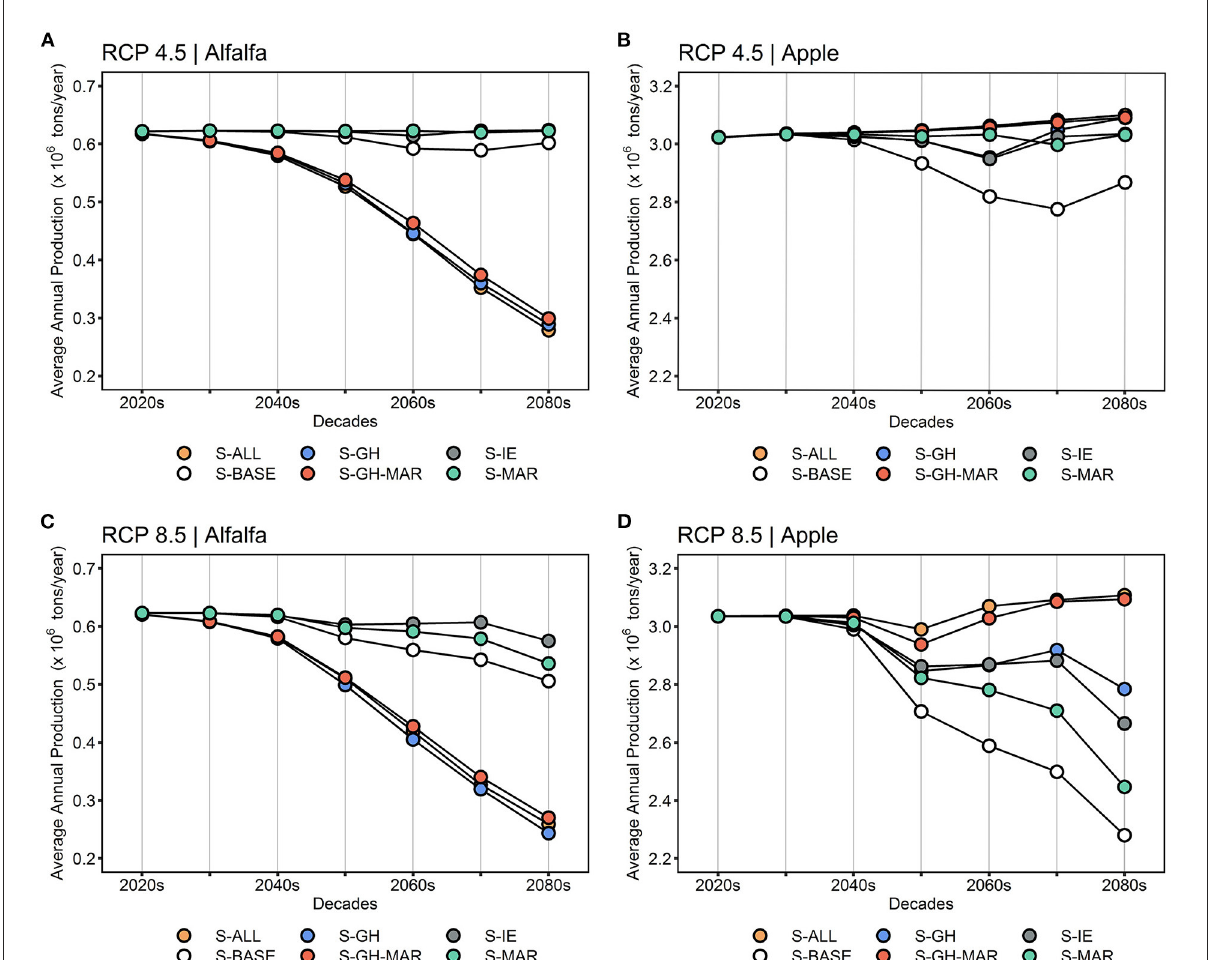
FIGURE14 Average annual crop production within each decade for apple and alfalfa under six scenarios for (A,B) RCP 4.5 and (C,D) RCP